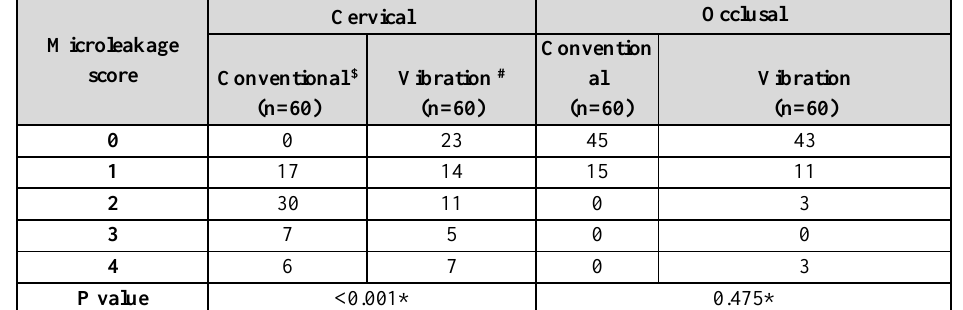
Table 5: Microleakage scores of the cervical walls compared to that of occlusal walls, by condensation method.